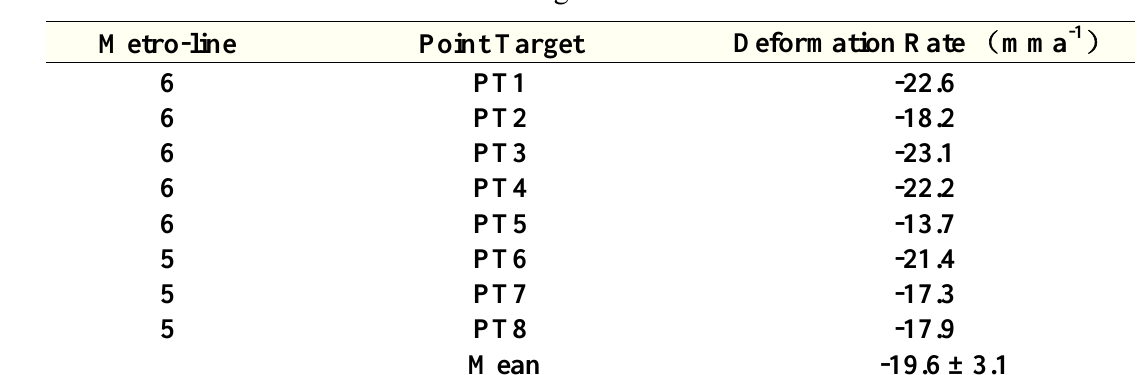
Table 3. Point targets in Datansha